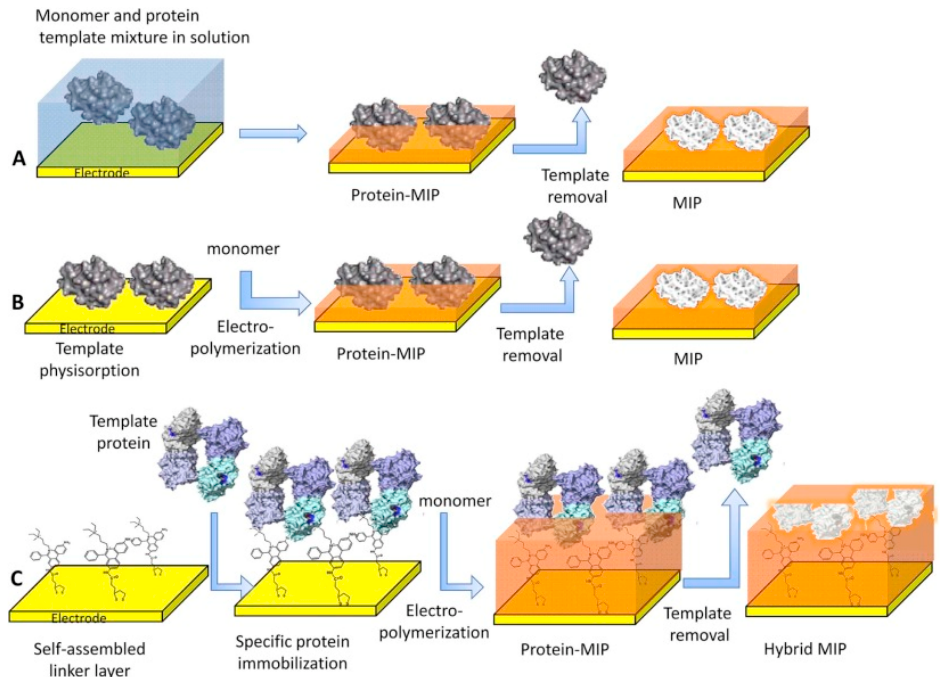
Figure 2. The various surface-imprinting approaches for selective recognition of proteins: ( A ) elec- tropolymerization; ( B ) preconcentration of the protein on the electrode surface; and ( C ) self-assembly on an anchor layer. Reprinted from [1] with permission from Erd ő ssy et al.